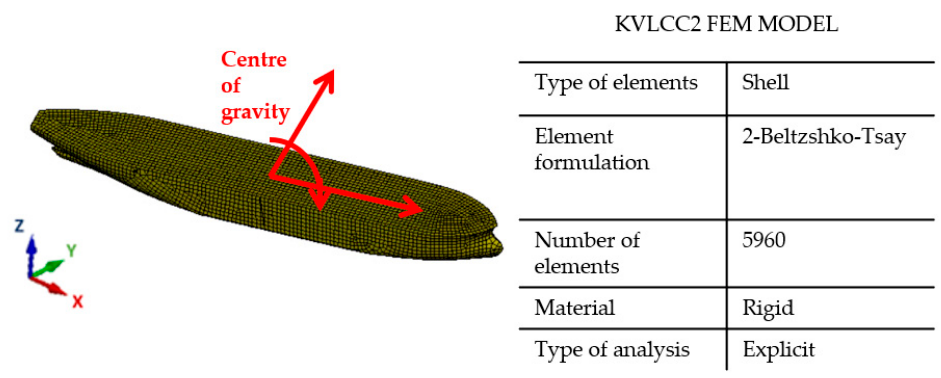
Figure 2. Forces generated with LS-DYNA subroutine.